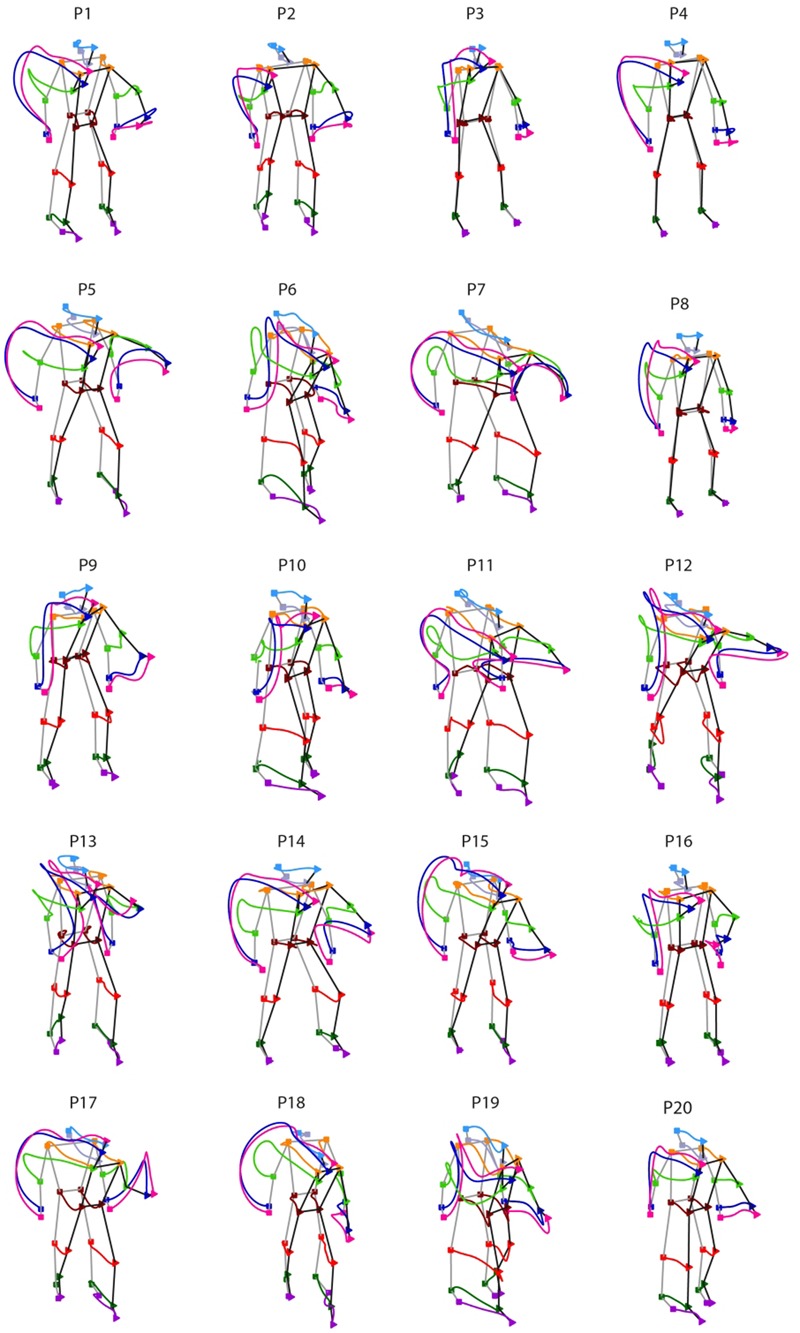
Inter-individual variability in throwing styles. Individual throwing styles are shown for the 20 participants recruited in the study. For each thrower, the displayed curves represent the averaged joint-markers trajectories across all trials performed. Square and triangle symbols indicate respectively the beginning of the throwing action and the time of ball release. Remarkable inter-individual differences are observed in the participants sample.